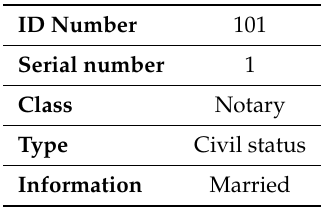
Table 1. Transaction